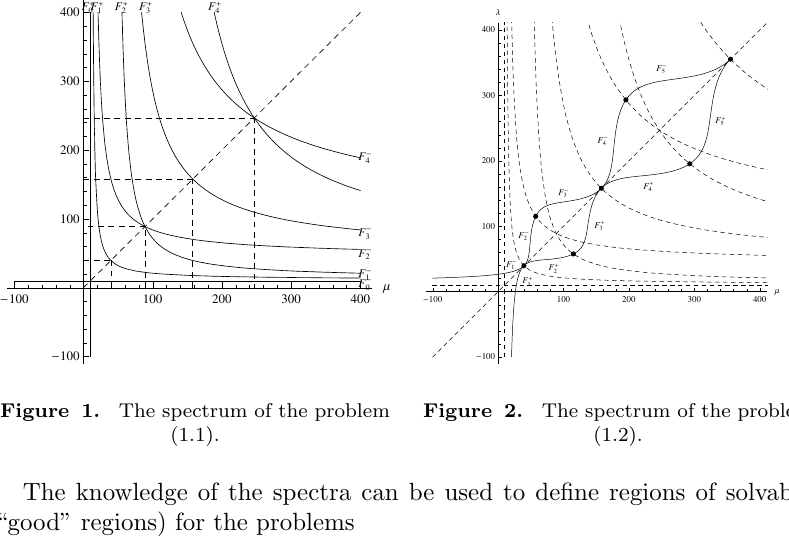
Figure 1. The spectrum of the problem (1.1).